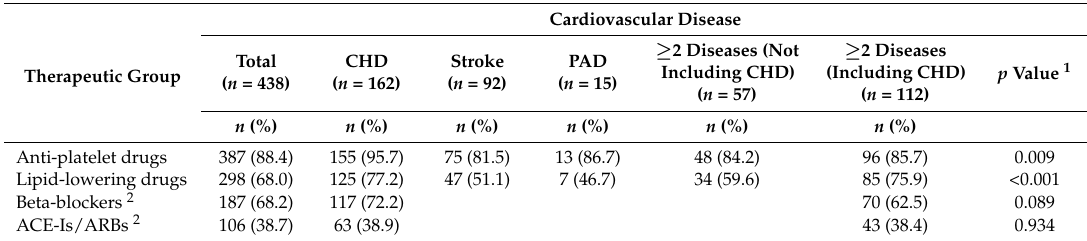
Table 3. Distribution of patients who received the recommended drug therapies by therapeutic group and type of cardiovascular disease.